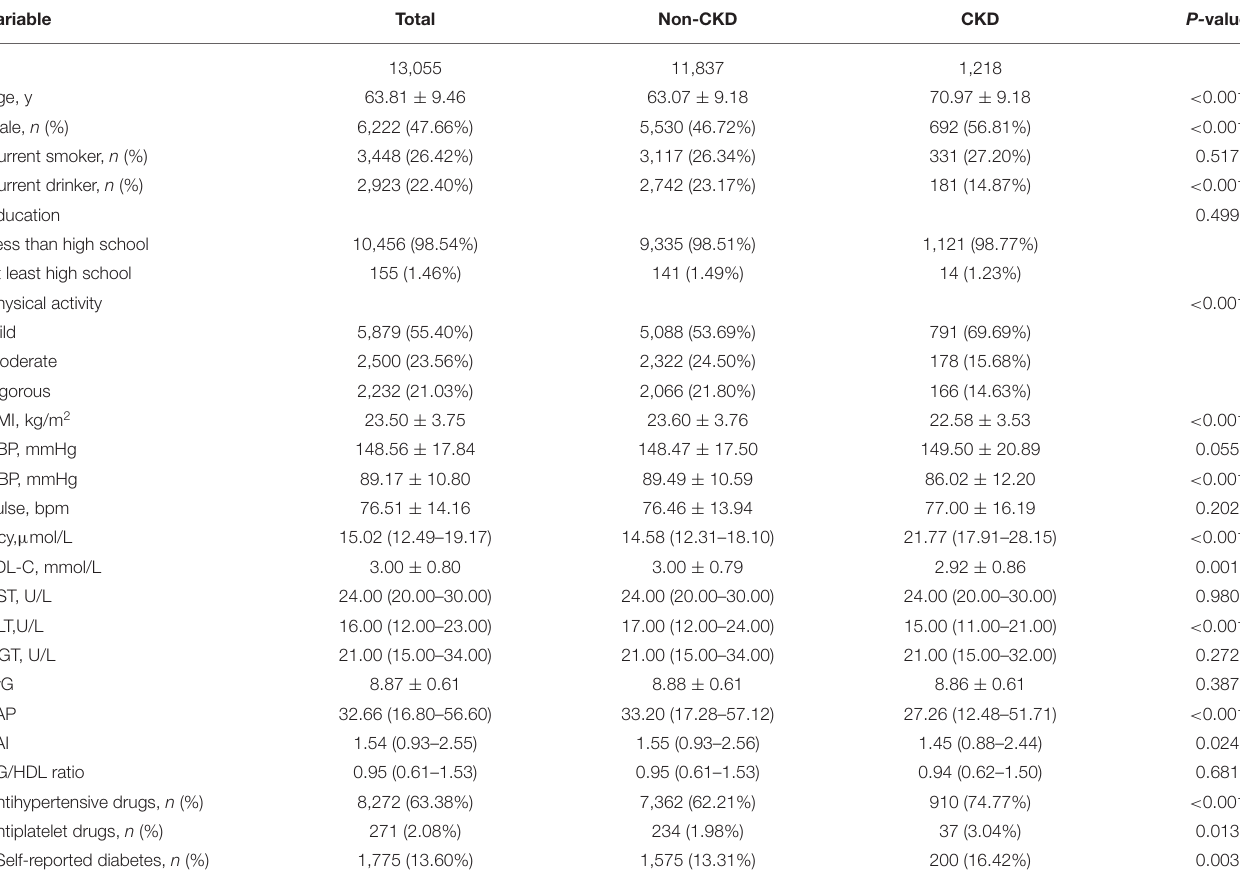
TABLE 1 | Baseline characteristics of study participants a